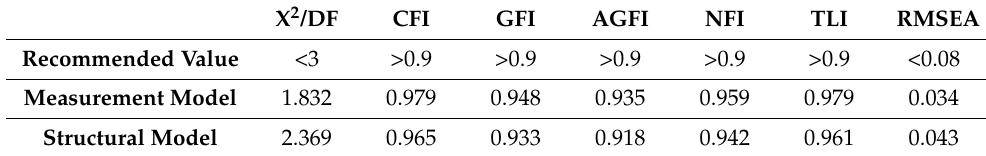
Table 5. Model-fit indices of the measurement model and structural